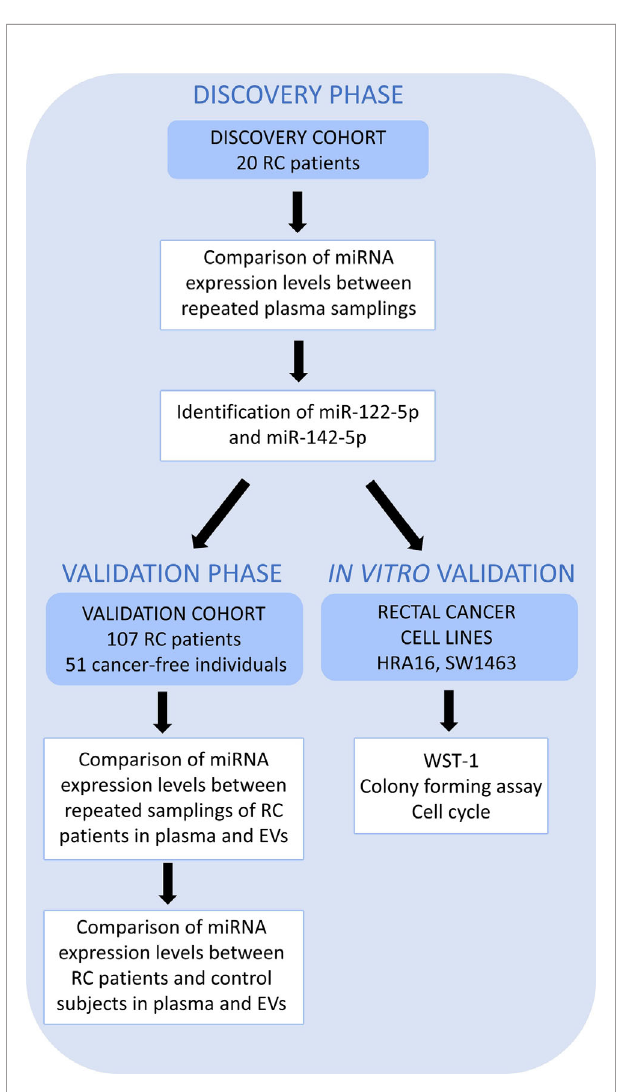
FIGURE 1 | A schematic overview of the work fl ow. High throughput sequencing (Discovery cohort – 20 RC patients) was performed on whole plasma collected at 2 sampling occasions to identify those miRNAs differentially expressed between two samplings (the fi rst, at the time of diagnosis, T0 and the second, a year after the diagnosis, T1). miR-122-5p and miR-142-5p were validated in plasma and further in plasma EVs on an independent group of RC patients (n=107, Validation cohort) at the same 2 sampling occasions. Both miRNAs were also investigated in a control group consisting of cancer-free individuals (n=51) by RT-qPCR. The effect on cell proliferation, survival, and cell cycle was also studied on rectal cancer cell lines ( in vitro studies